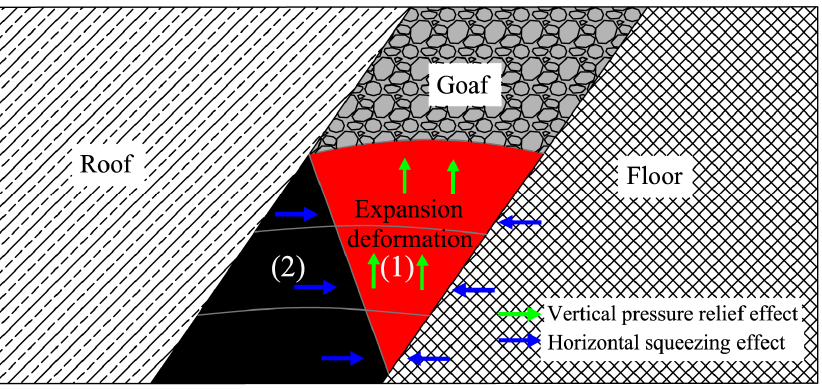
Figure 6. The expansion deformation mechanism: (1) denotes the pressure relief zone, and (2) denotes the stress concentration zone.